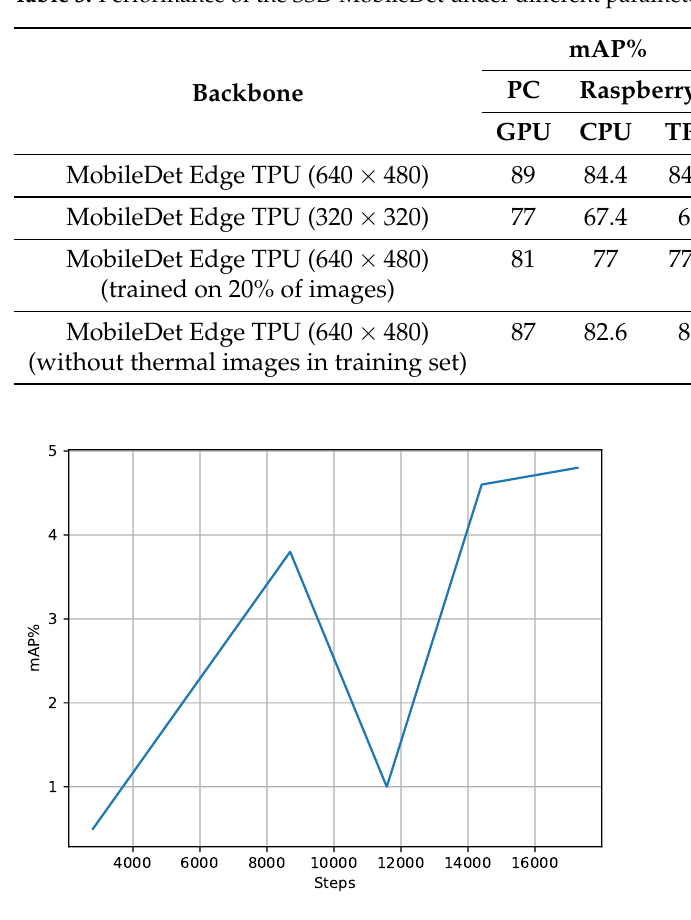
Figure 12. mAP of the SSD MobileDet model, trained on the images without leaves and tested on the images with